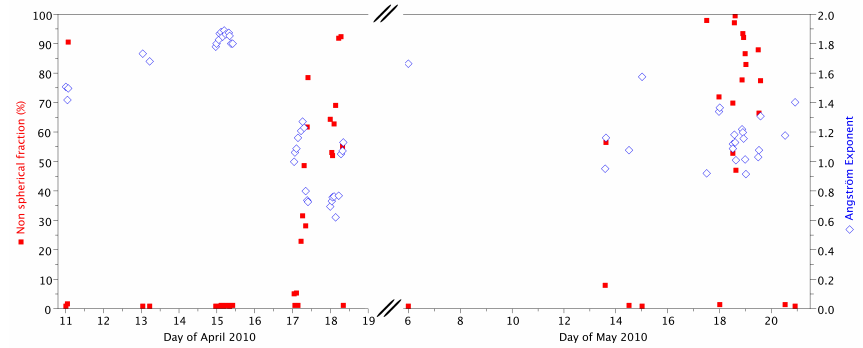
Fig. 2. Time series of Angstr¨om exponent, α = − d ‘n( AOD ) (cid:14) d ‘n(λ) , computed between 440 and 870nm and fraction in % (red squares) of non-spherical particles for April and May 2010 over Lille.